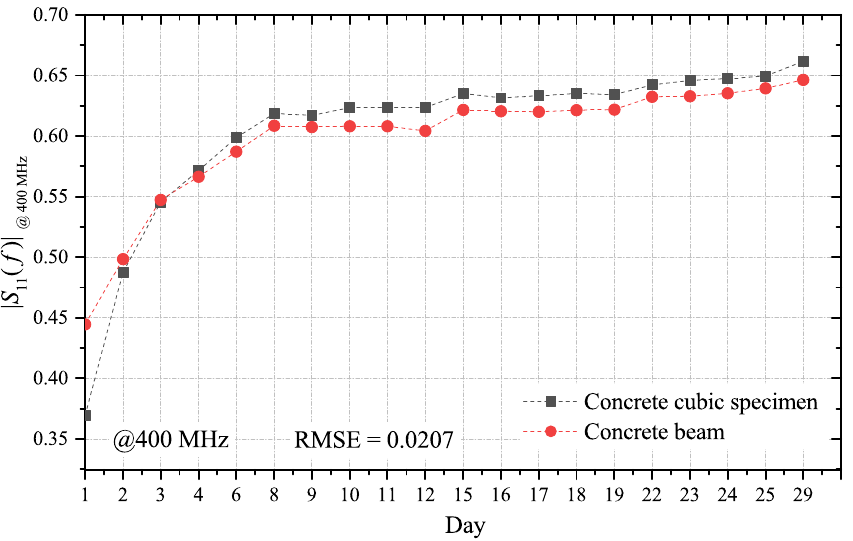
Figure 8. Comparison of the | S 11 | , measured at 400 MHz, during the observation period: from the PCP in the specimen (black squares) and from the PCP in the beam (red circles).